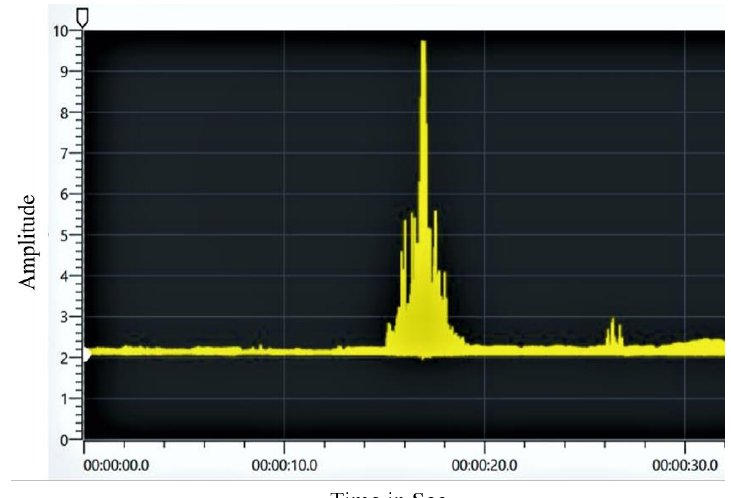
Figure 9. Representation of the Doppler frequency shift of 2 objects placed at an angle of 35 0 and 50 0 in the frequency domain, respectively.